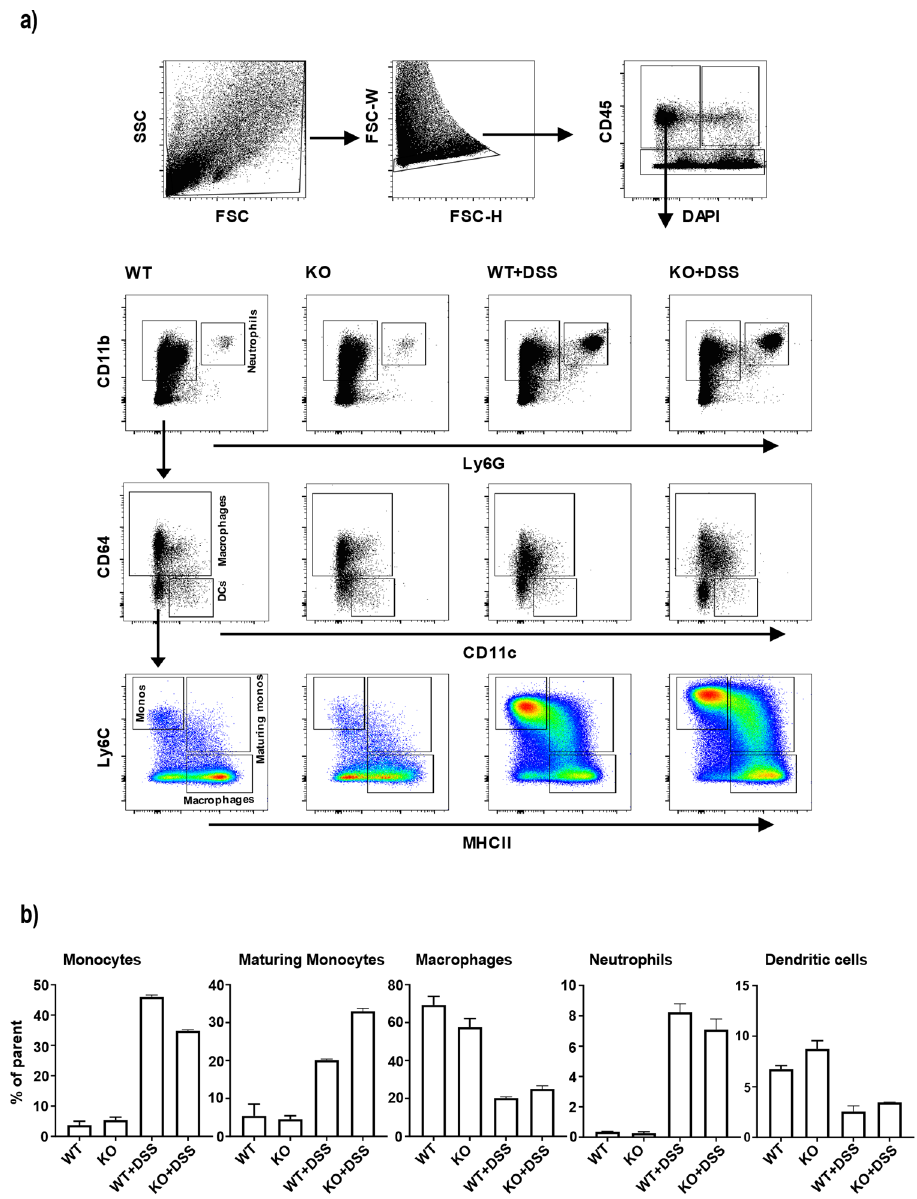
Figure 3. Immune cell composition in the colons of wild-type and miR-511-deficient mice. Immune cell populations of colons from WT and miR-511-deficient mice were analyzed using flow cytometry. The following gating strategy was used: ( a ) Debri was excluded using forward scatter (FSC) and side scatter (SSC) gating, followed by excluding doublets by FSC-H and FSC-W gating. Live leukocytes were selected as DAPI-CD45+. The resulting cells were then analyzed for CD11b, Ly6G, CD11c, CD64, Ly6C, and MHCII to identify neutrophil, DC, monocyte (monos), maturing monocyte (maturing monos) and macrophage populations. ( b ) Relative contribution of different immune cell populations in control (WT, KO) and DSS groups (WT+DSS, KO+DSS), respectively. Neutrophil (CD11b+Ly6G+), dendritic cell (CD11b+Ly6G-CD64-CD11c+), monocyte (CD11b+Ly6G- CD64+Ly6C+MHCIIa-), maturing monocyte (CD11b+Ly6G-CD64+Ly6C+MHCIIa+), macrophage (CD11b+Ly6G-CD64+Ly6C-MHCIIa+) contributions are indicated as percentage of parent gate. These data represents pooled data of two independent experiments with 5 mice per group per experiment. Error bars indicate standard error of the mean.